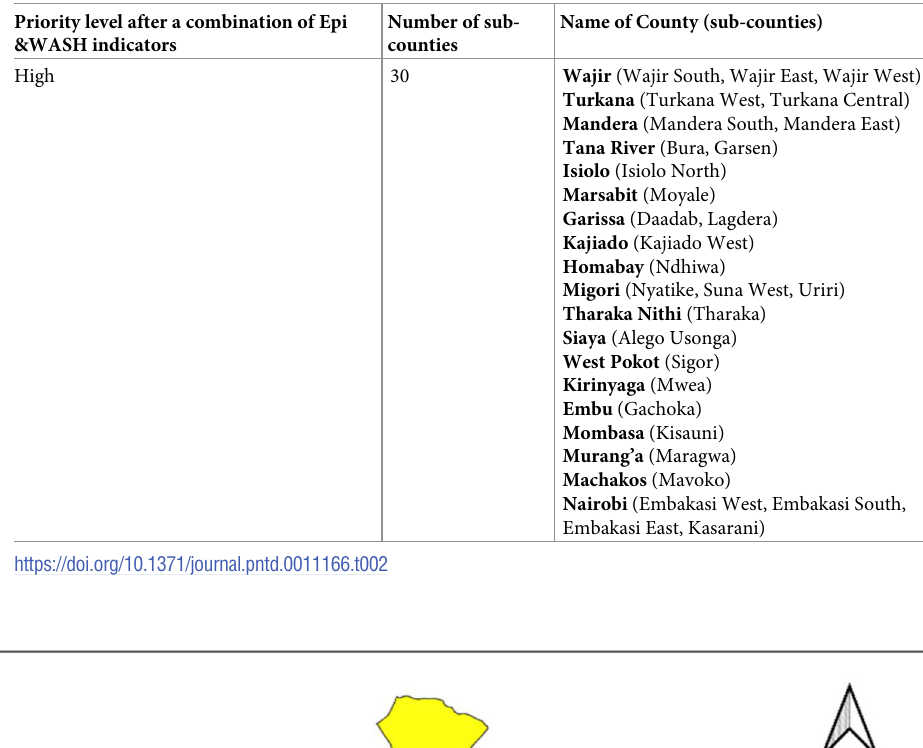
Table 2. List of High priority sub-counties after a combination of epidemiological and WASH indicators in Kenya, 2015–2019.